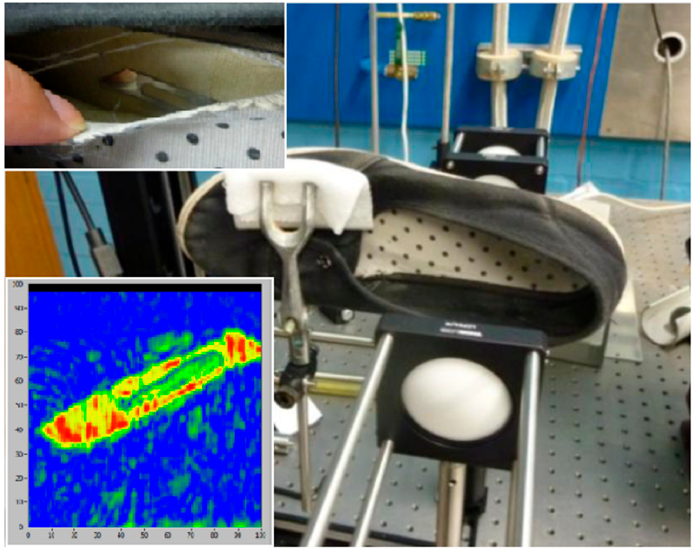
Figure 7. Imaging in reflection mode, showing a hidden object in shoe lining.